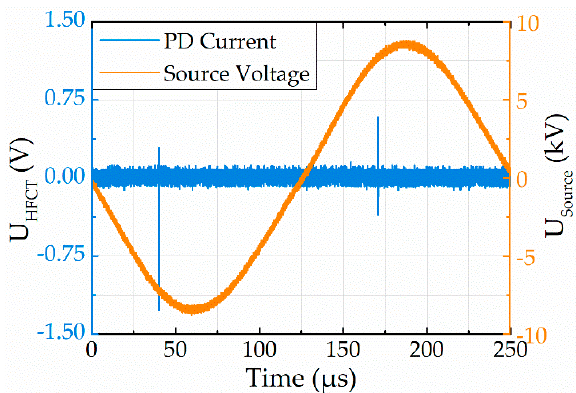
Figure 4. Typical partial discharge (PD) current and voltage signal under f = 4 kHz and U p ‐ p = 20 kV.